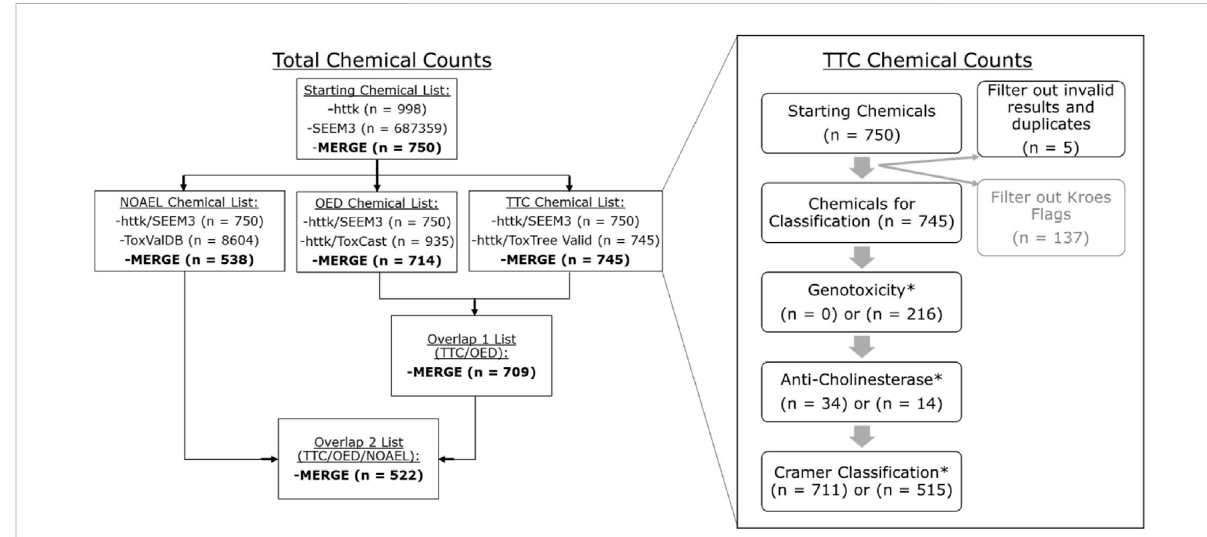
FIGURE 1 Totalchemicalcountsandwork fl owforthehttkdatasetforboththeentirestudy(left)andforgenerationofspeci fi cTTCcategorizations(right). The total chemical work fl ow began with chemicals in both the chem. physical and in vitro .data list embedded in httk ( n = 998) and the SEEM3 published values (Ring et al., 2019)( n > 600 k) list. Lists for TTC, OED, and NOAEL MoE calculations are separated out based on data available for the httk chemicals from a unique source (ToxTree, ToxCast, and ToxValDB, respectively). The number of chemicals in the merge between those datasets is shown in bold. Finally, the overlap between TTC and OED lists yields 709 chemicals while the overlap between TTC/OED/NOAEL listsyields522chemicals.TheTTCwork fl owdidnotutilizetheKroesexclusionstep(greyedout),whichisdiscussedinmoredetailinSection4.1.The work fl ow was run twice, excluding ( n = 0) or including ( n = 216) the genotoxicity fi